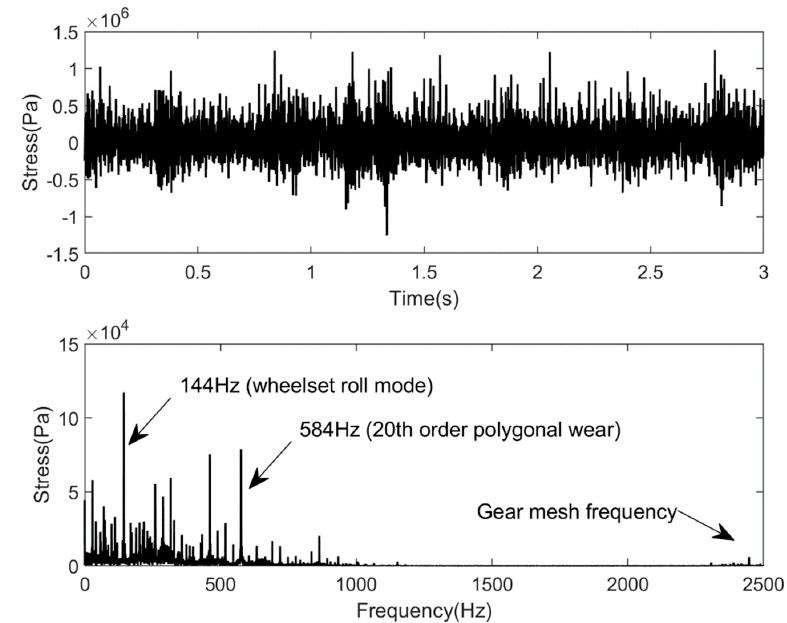
Figure 22. Gearbox dynamic stress.